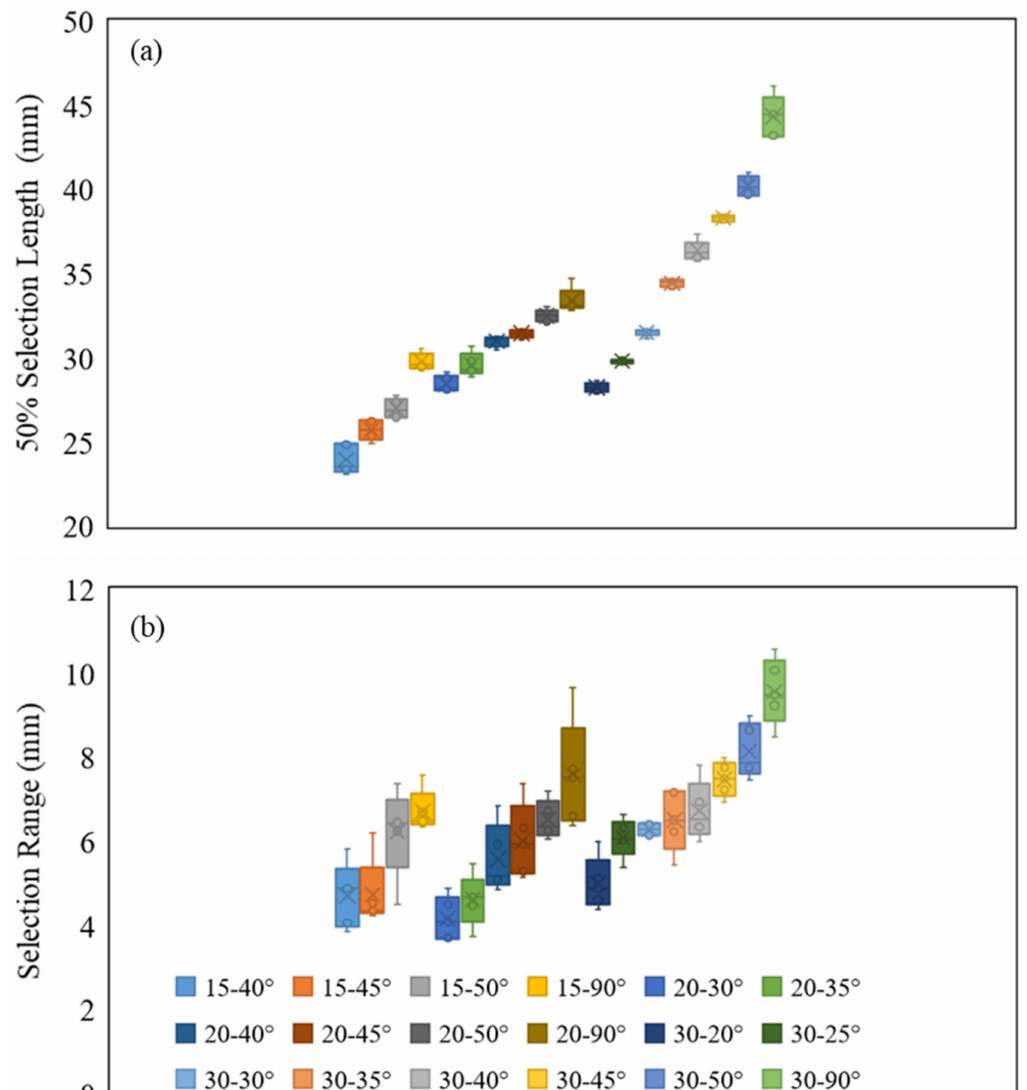
Figure 5. ( a ) Values of L 50 (lengths of krill at which 50% of the individuals are not captured) associated with different mesh sizes and mesh opening angles; ( b ) SR (selective range: difference between L 75 and L 25) associated with different mesh sizes and mesh opening angles. The figures before and after the hyphen in the legend are the mesh size and mesh opening